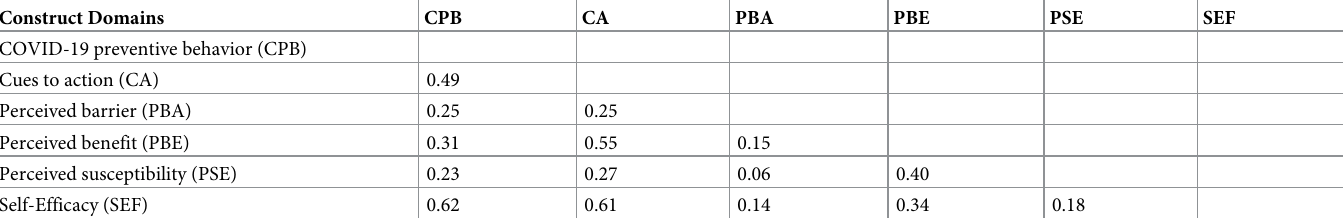
Table 6. Heterotrait-Monotrait (HTMT) discriminant validity test result of the instrument used to assess students COVID-19 preventive behavior based on the Health Belief Model in Gondar city, Northwest Ethiopia, 2020 (n = 370). Construct